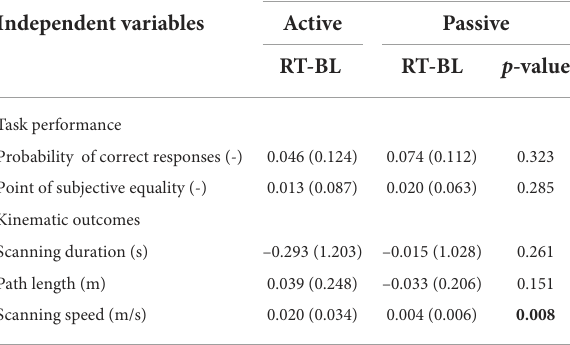
TABLE 5 The results for each motivation subscale comparing the differences between initial baseline (iBL) active and initial baseline passive.